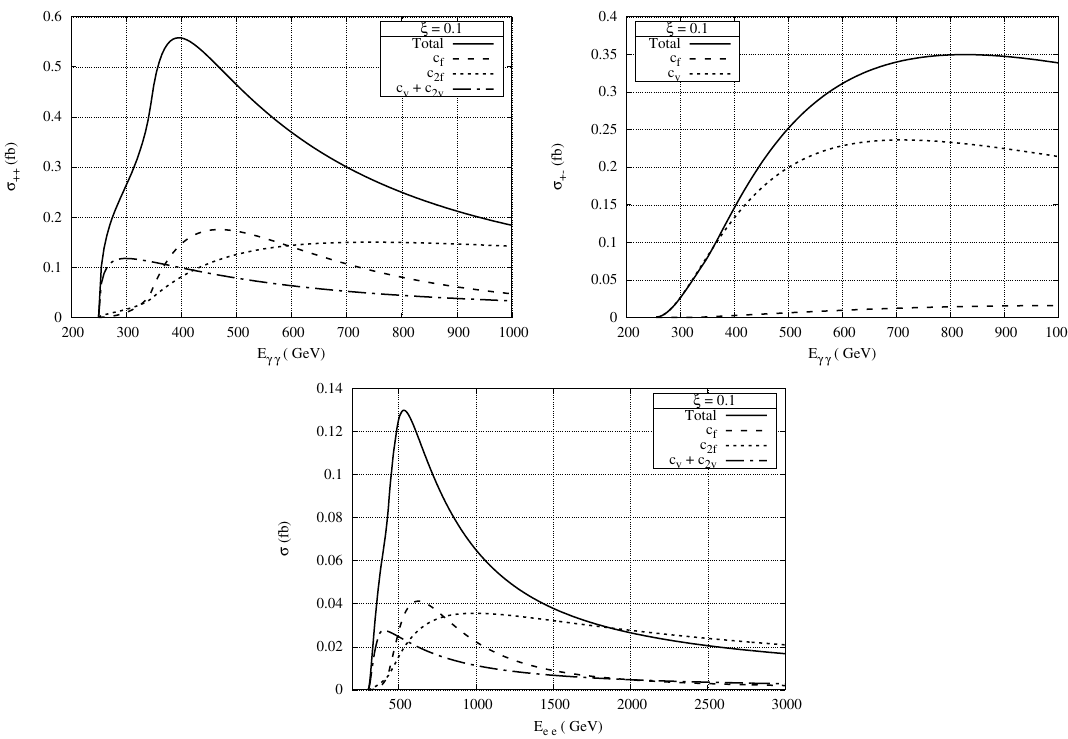
Figure 14 . MCHM5: cross-sections for the individual contributions as given in tables 1 and 3 for γγ → hh same photon helicities (top left panel), opposite photon helicities (top right panel) and e + e − → hh (bottom